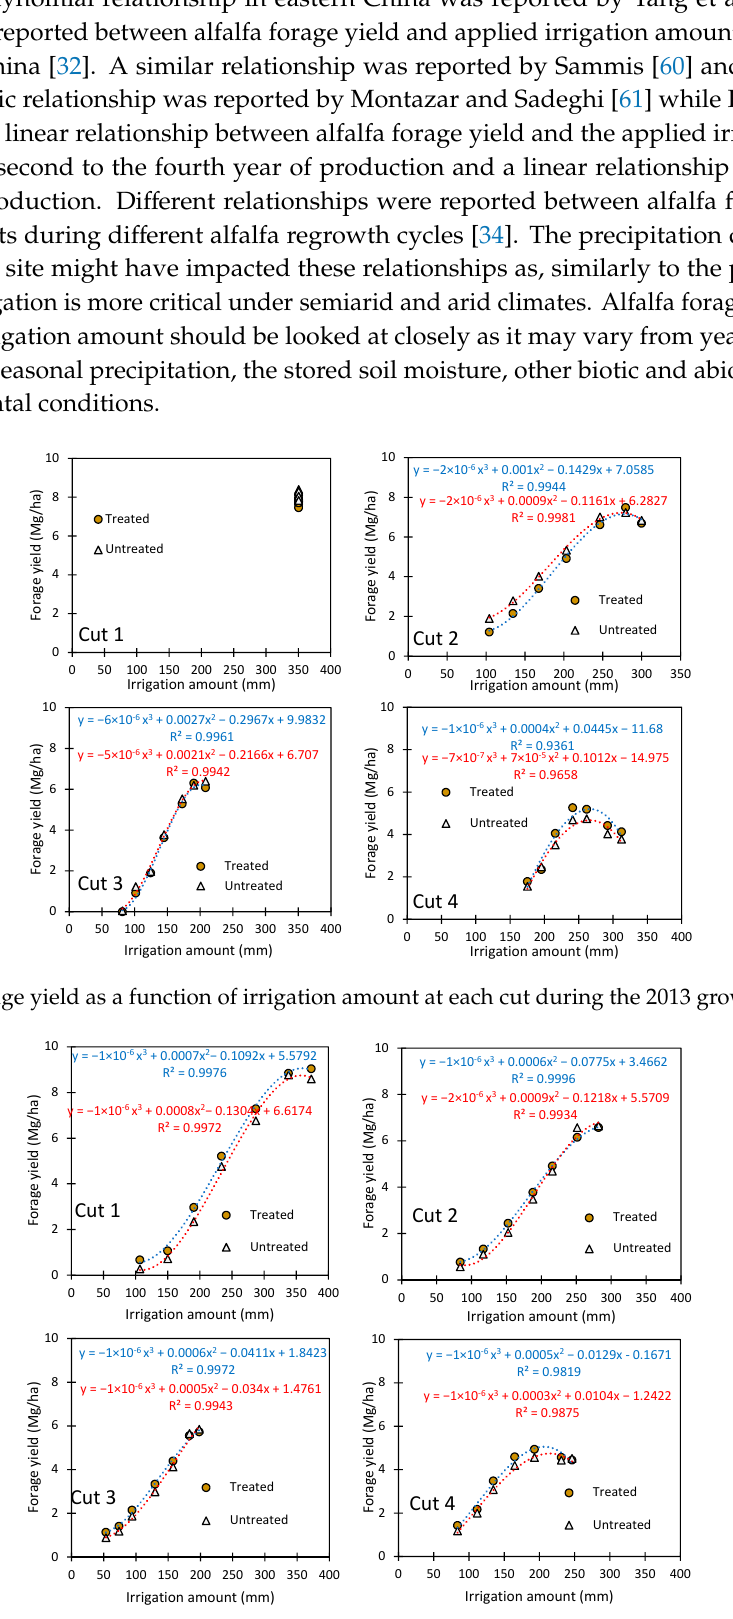
Figure 3. Forage yield as a function of irrigation amount at each cut during the 2014 growing season.